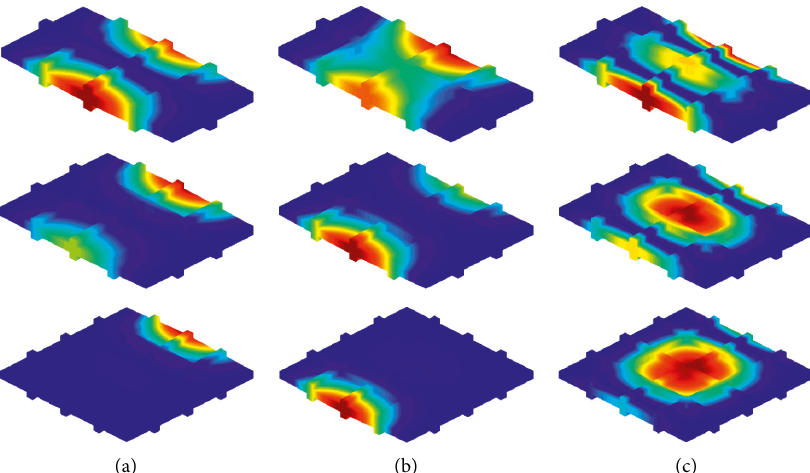
� 0 . 17, η 1 =0.142, CNT